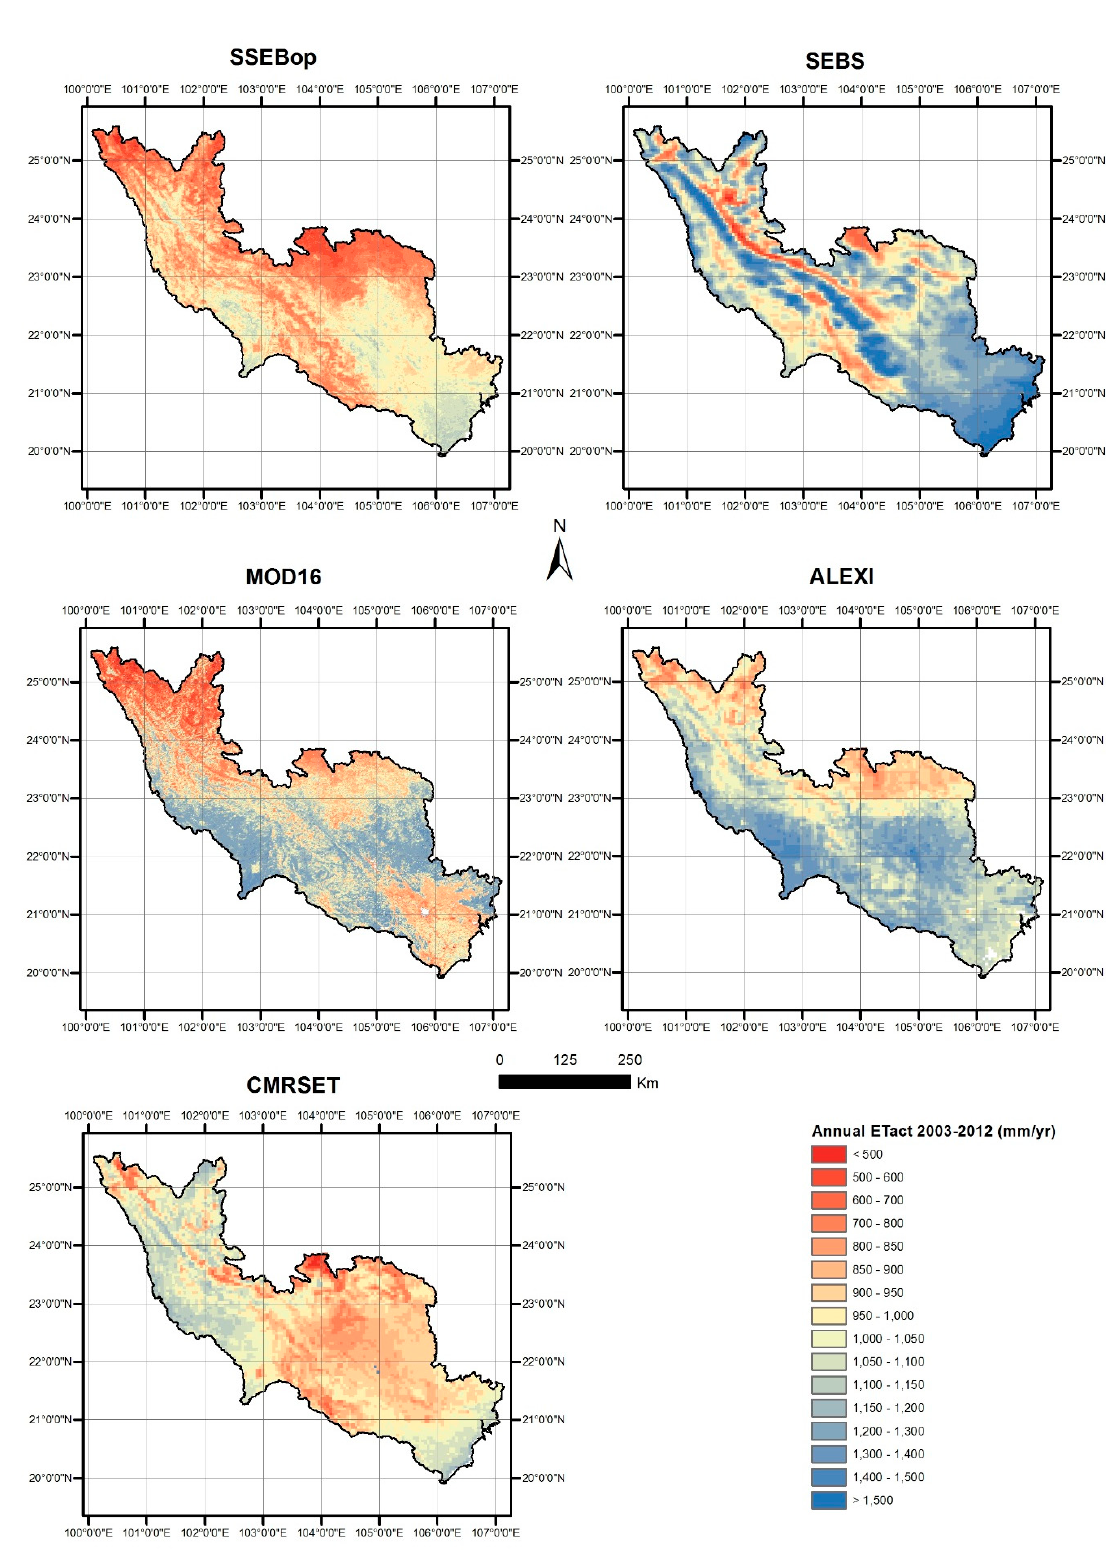
Figure A3. Overview of annual ET act in the Red River Basin according to five different GSDPs.